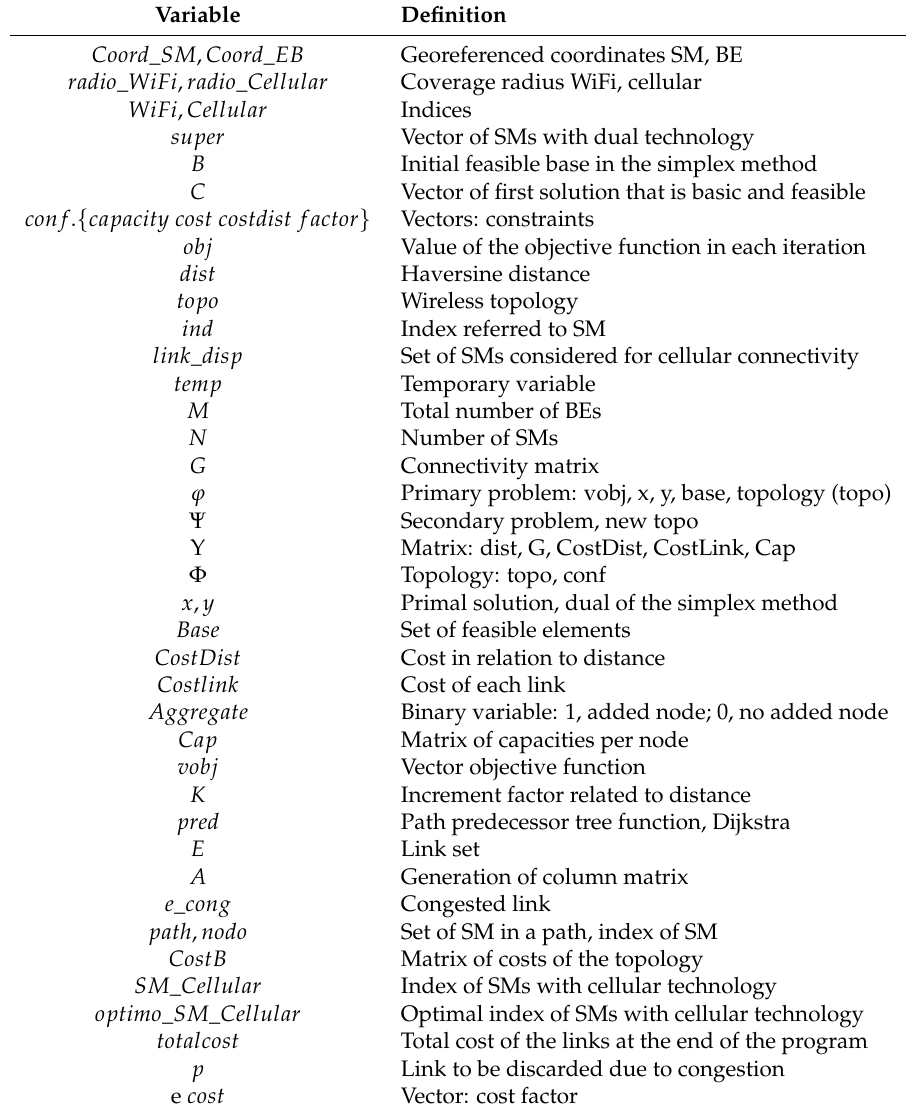
Table 3. General notations in CMCF-AMI